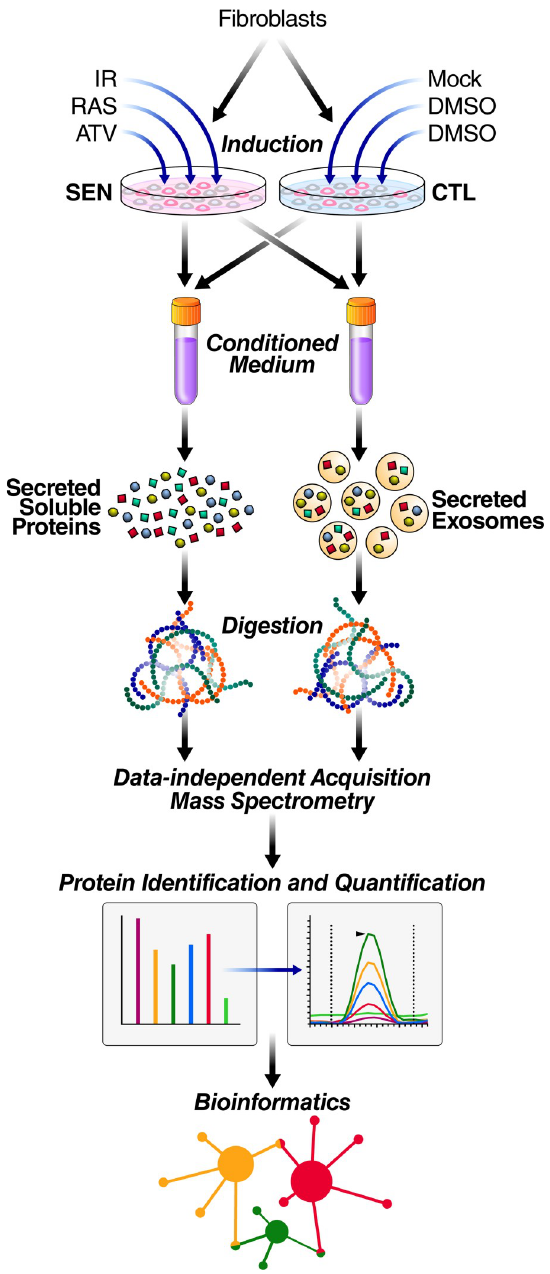
Fig 1. Proteomic workflow for isolation and analysis of secreted proteins and exosomes/EVs. Senescence was induced in cultured primary human lung fibroblasts by either IR, RAS, or ATV. Quiescent control cells were either mock irradiated or vehicle treated. Soluble proteins and exosomes/EVs were then isolated from conditioned media. Samples were digested and subjected to mass spectrometric analysis (DIA), followed by protein identification and quantification using Spectronaut Pulsar [32] and by bioinformatic, pathway, and network analyses in R and Cytoscape [33,34].ATV, atazanavir treatment; CTL, Control; DIA, data-independent acquisition; EV, extracellular vesicle; IR, X- irradiation; RAS, inducible RAS overexpression; SEN,